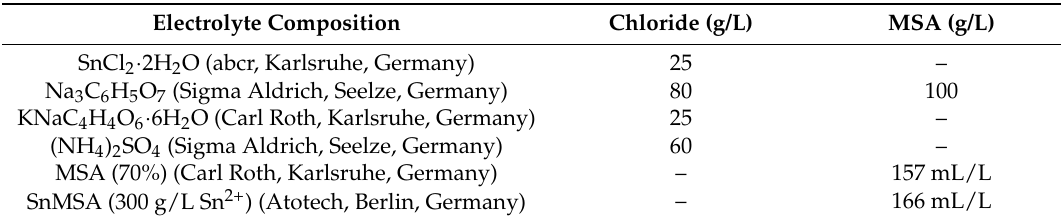
Table 1. Composition of the chloride based and methane sulfonic acid (MSA) electrolytes. Electrolyte